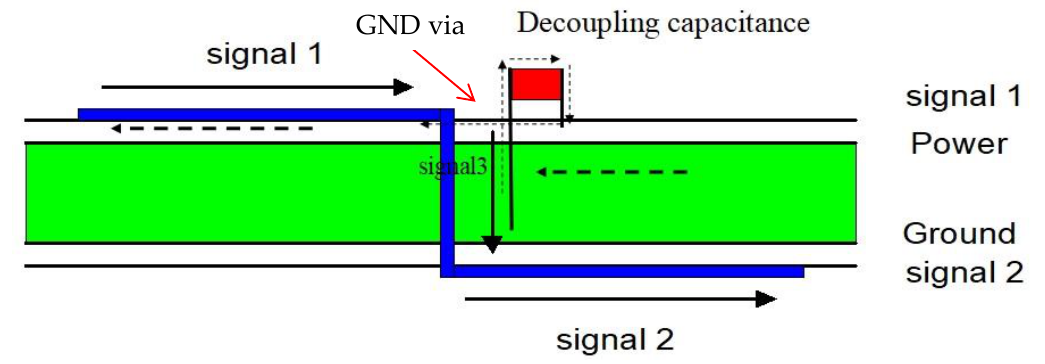
Figure 6. Schematic diagram of decoupling capacitance.